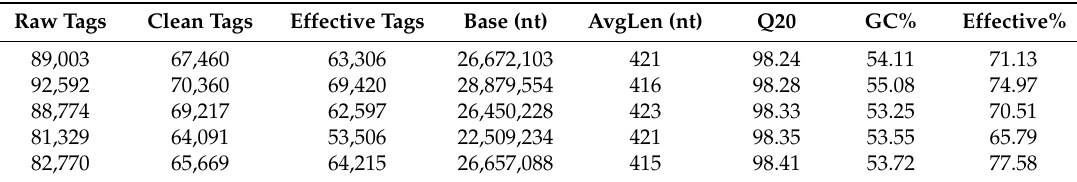
Table 2. Sequencing results from five samples.